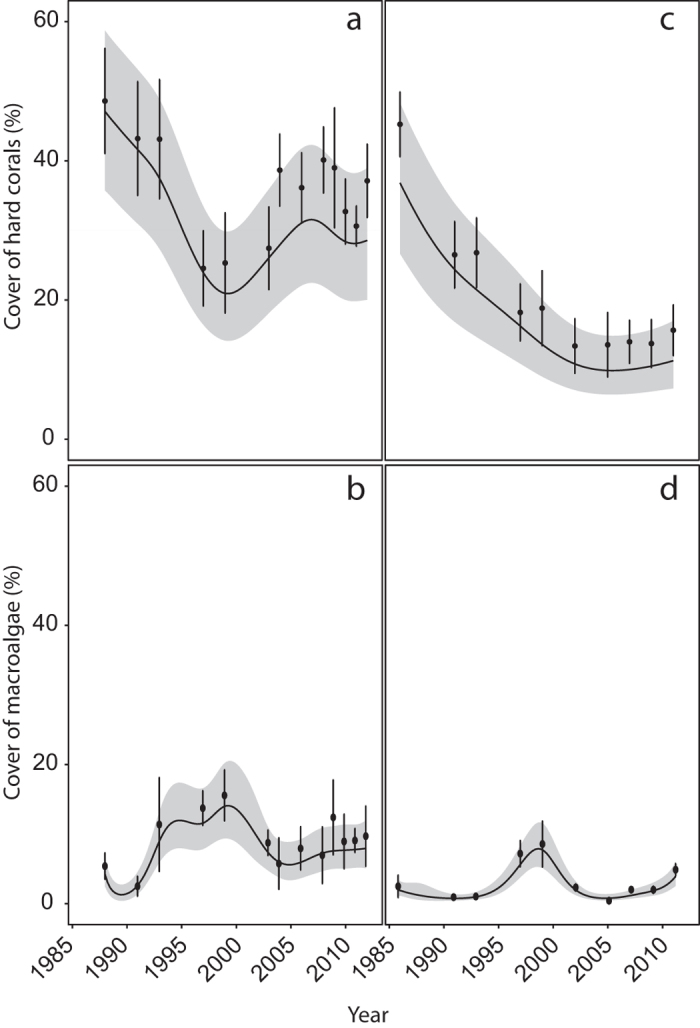
Changes in mean % cover (±SE, n = 6–10) of hard coral (a,c) and macro algae (b,d) at shallow (a,b) and deep sites (c,d). The fitted line is the predicted covers based on the binomial GAMM model (see Methods), shaded areas are confidence intervals.